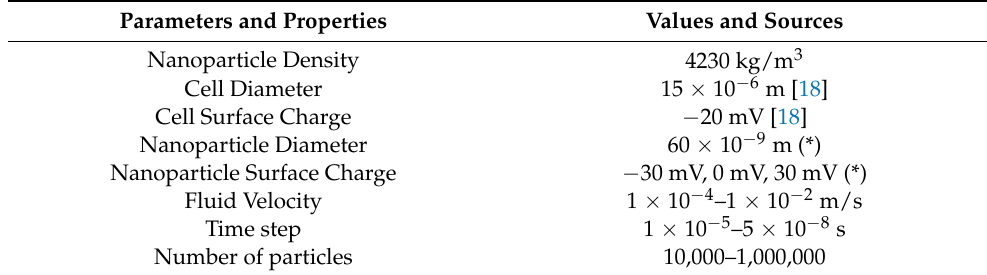
Table 2. Additional properties and parameters for the nanoparticle trajectory tracking model. (*experimental